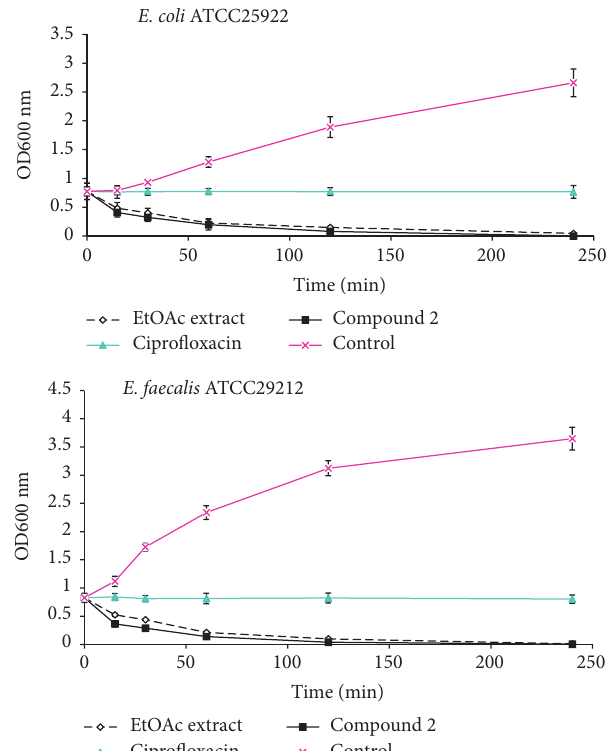
Figure 2: Bacteriolytic effect of EtOAc extract and compound 2 against E. coli and E. faecalis. The results represent the mean ± SD of the triplicate OD at each incubation